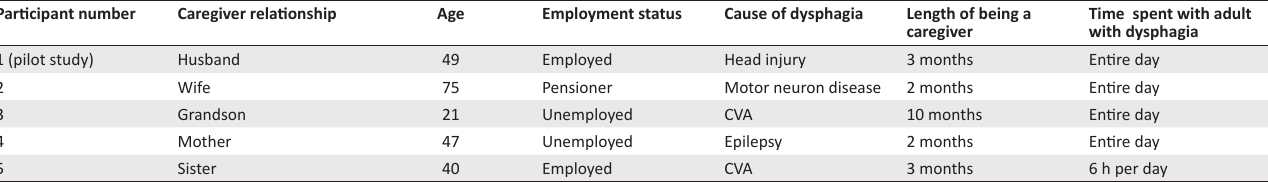
TABLE 1: Description of participants.